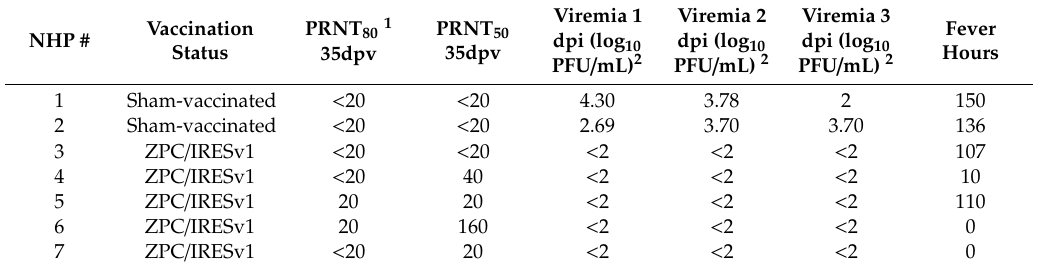
Table 3. ZPC / IRESv1 vaccination and protection in cynomolgus